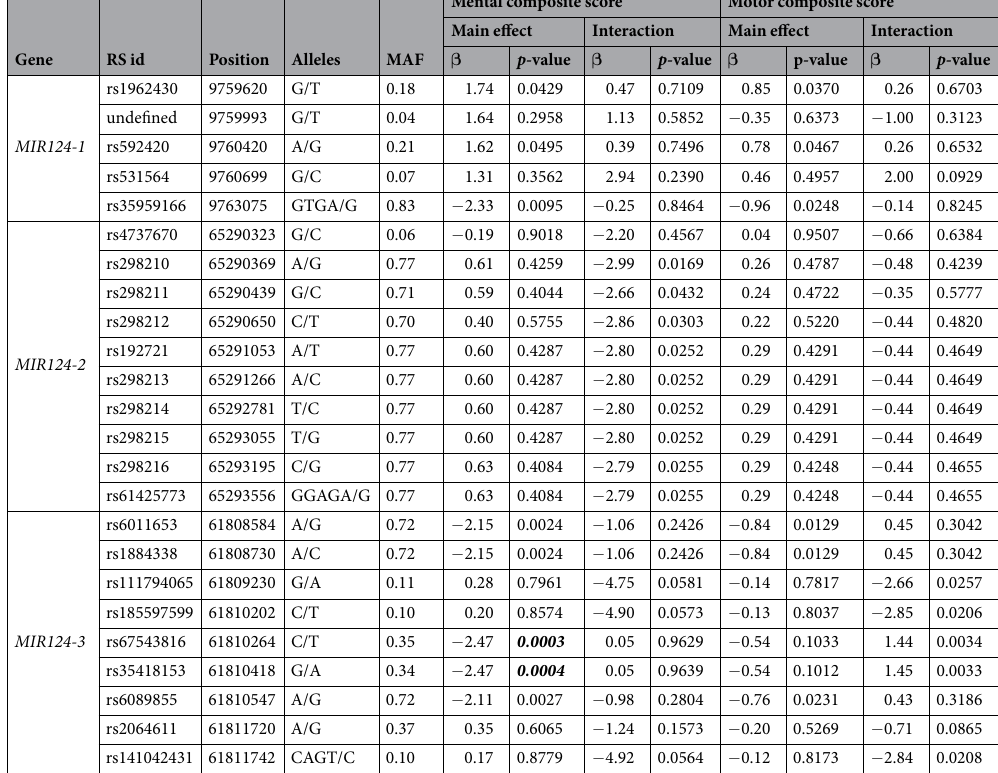
Table 2. Summary of miR-124 SNP association effect sizes and p-values in determining mental and motor composite score a . a Alleles are written in the format minor allele/major allele. A Bonferroni-corrected significance threshold of 0.05/96 = 0.00052 was used for individual SNP tests of association.